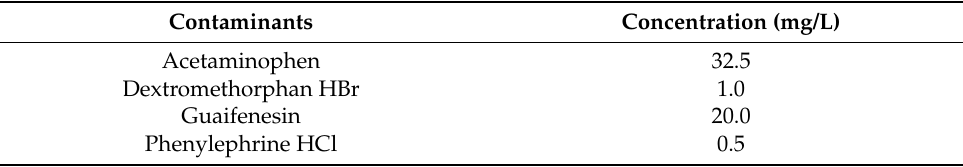
Table 5. Some APIs found in the WW Stream (References: [88,89]).